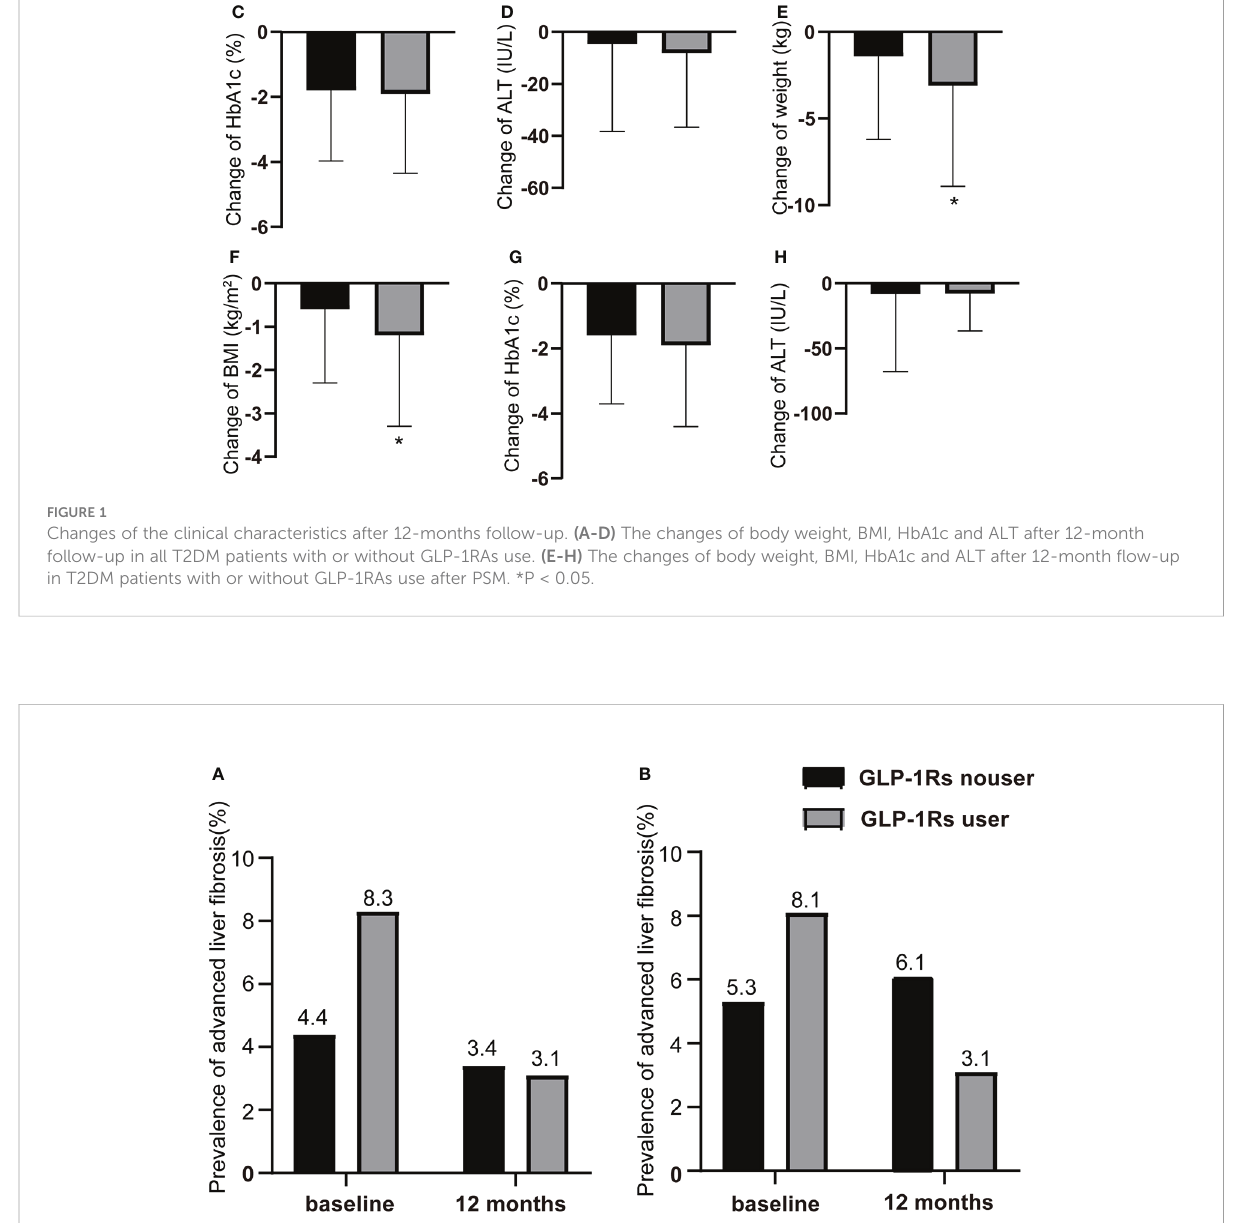
FIGURE 2 Change of the prevalence of advanced liver fi brosis after 12-month follow-up. (A) The prevalence of advanced liver fi brosis at baseline and 12- month follow-up in all T2DM patients with or without GLP-1RAs use. (B) The prevalence of advanced liver fi brosis at baseline and 12-month follow-up in T2DM patients with or without GLP-1RAs use after